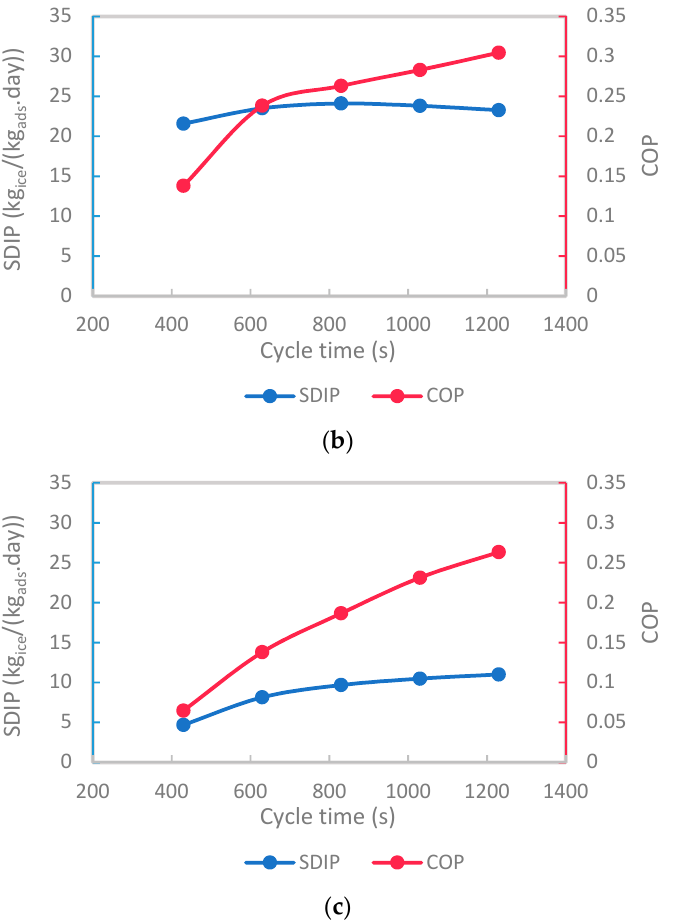
Figure 9. The specific daily ice production and coefficient of performance of the system under different cycle times and composite thicknesses of ( a ) 2 mm, ( b ) 5 mm, and ( c ) 10 mm. In the case of 2 mm composite thickness, the SDIP decreased gradually from its maximum value of 33.27 kg ice ·kg ads − 1 ·day − 1 at 430 s to 27.66 kg ice ·kg ads − 1 ·day − 1 at 1230 s. This re-